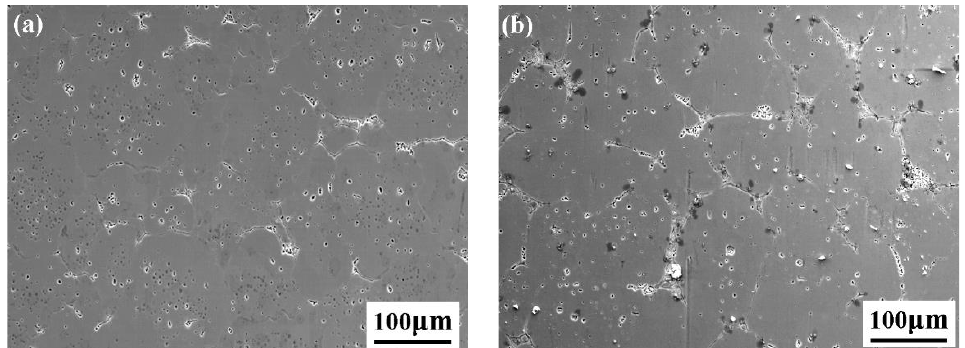
Figure 10. SEM photography of samples cut from the centre of the parts via semi-solid compression: ( a ) 620 °C; ( b ) 630 °C.